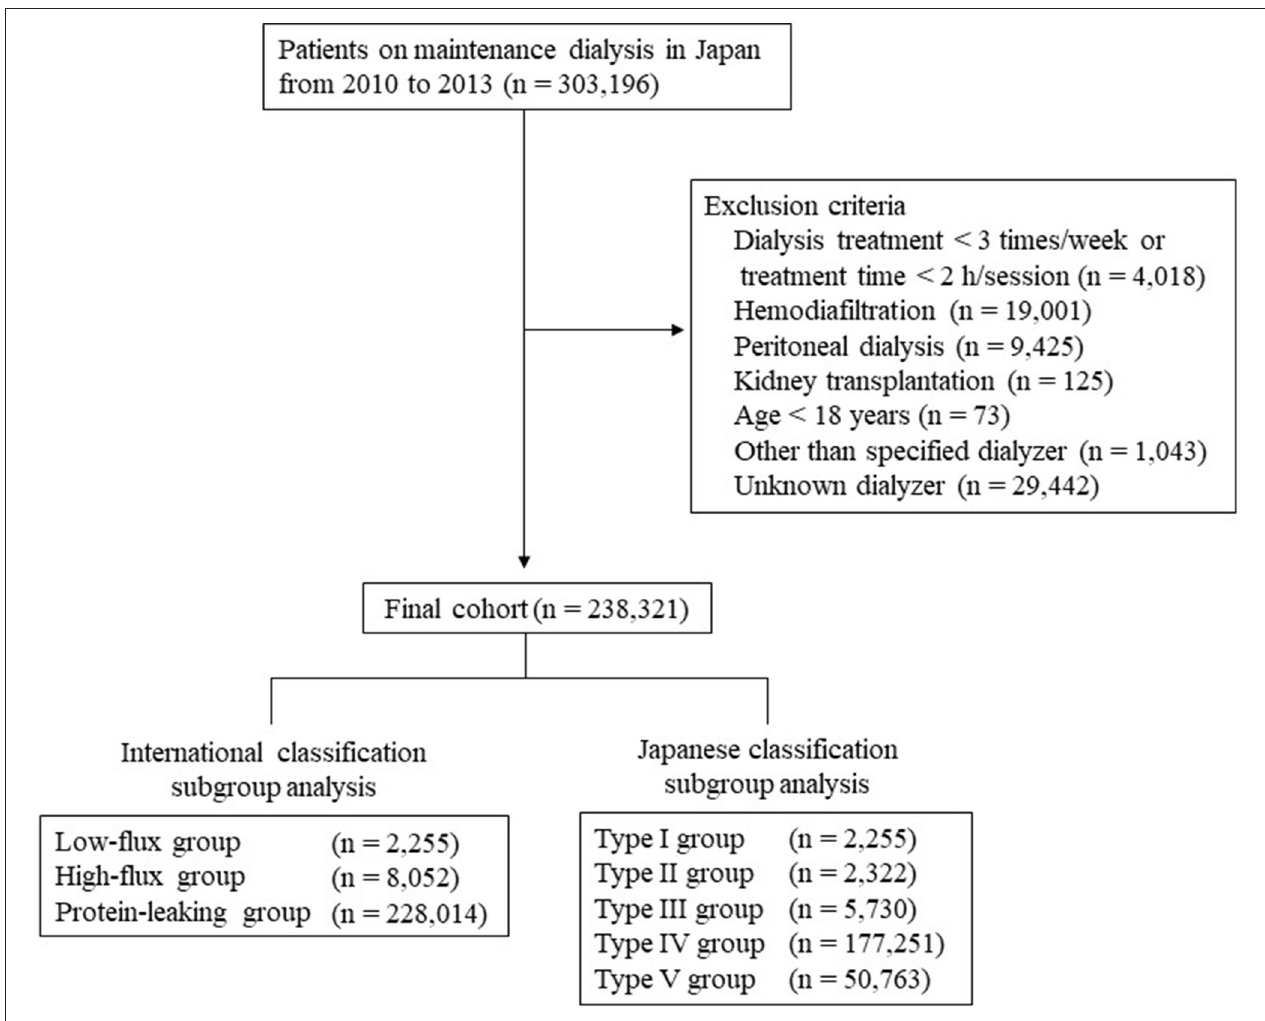
FIGURE 1 | Flowchart of study